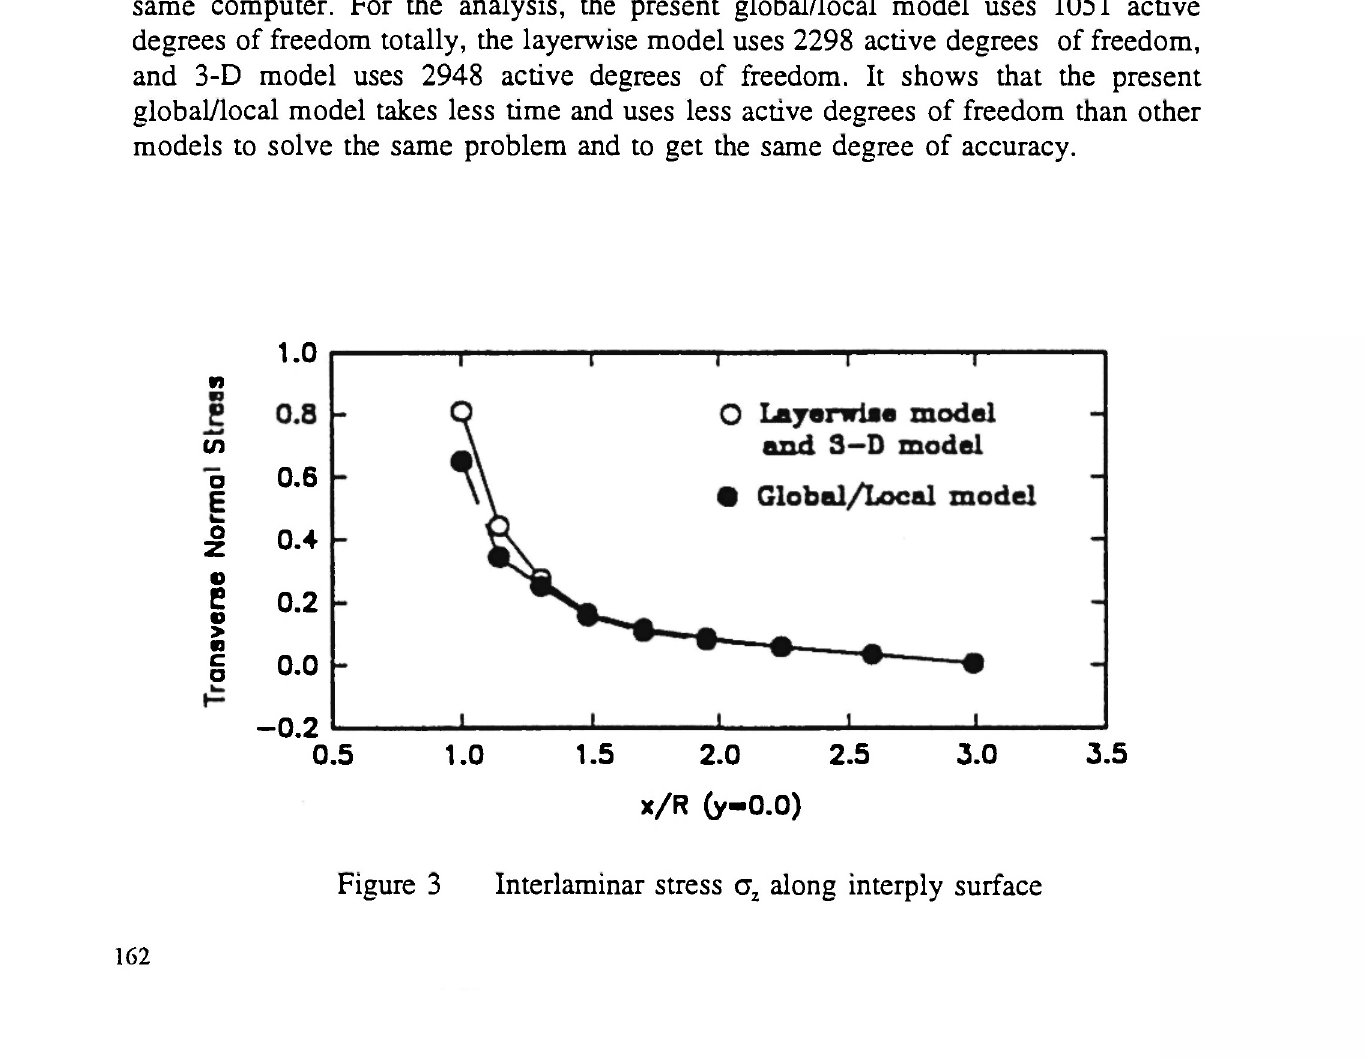
along interply ζ